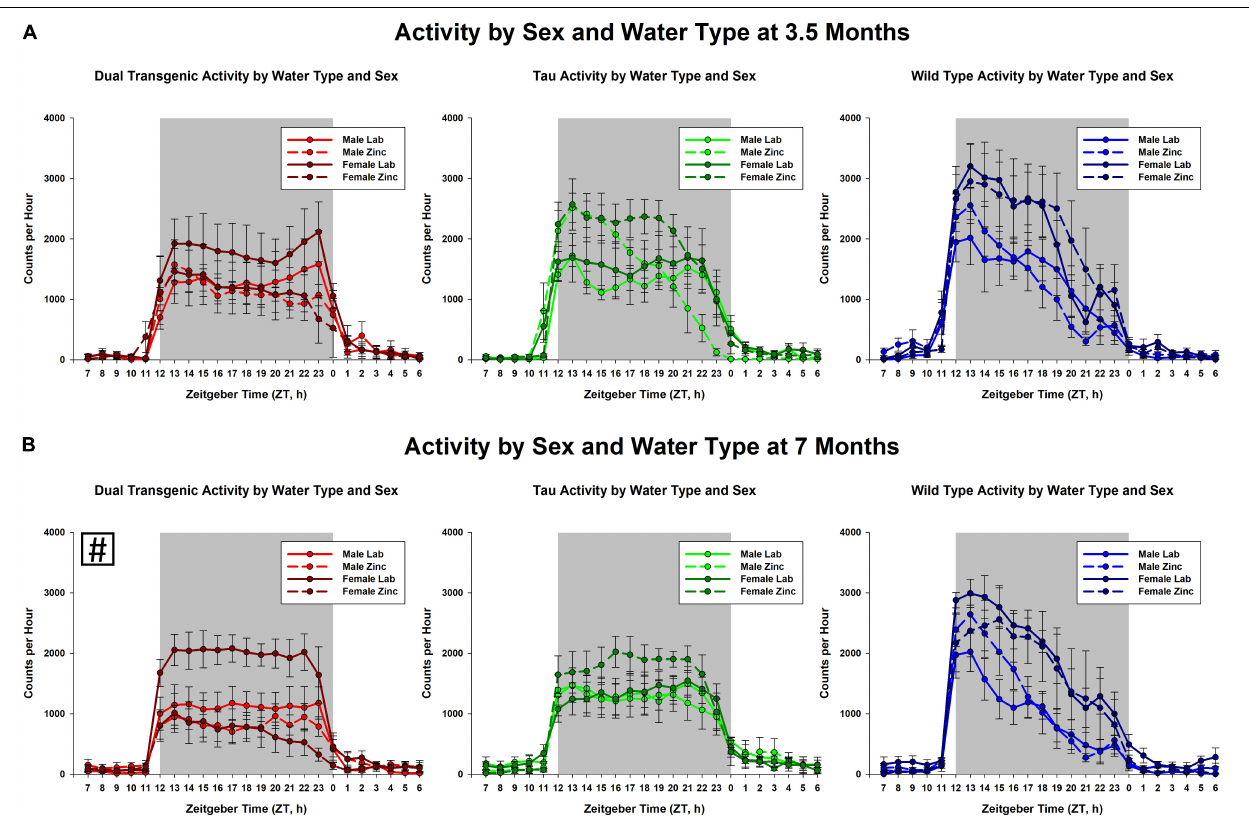
FIGURE 4 | Comparison dark cycle activity by (A) sex by water type by genotype at 3.5 months, and (B) sex by water type by genotype at 7 months. At 7 months, dual Tg females on lab water were significantly more active than either sex on Zn water, p < 0.05 (boxed # indicates a significant effect summed across dark cycle